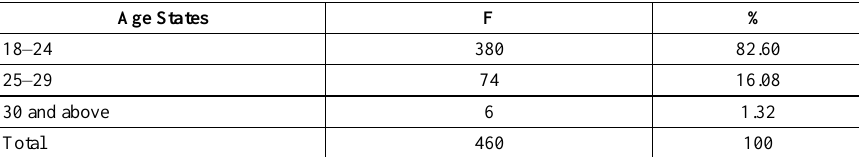
Table 3. Distribution of mechanical engineer programme candidates by